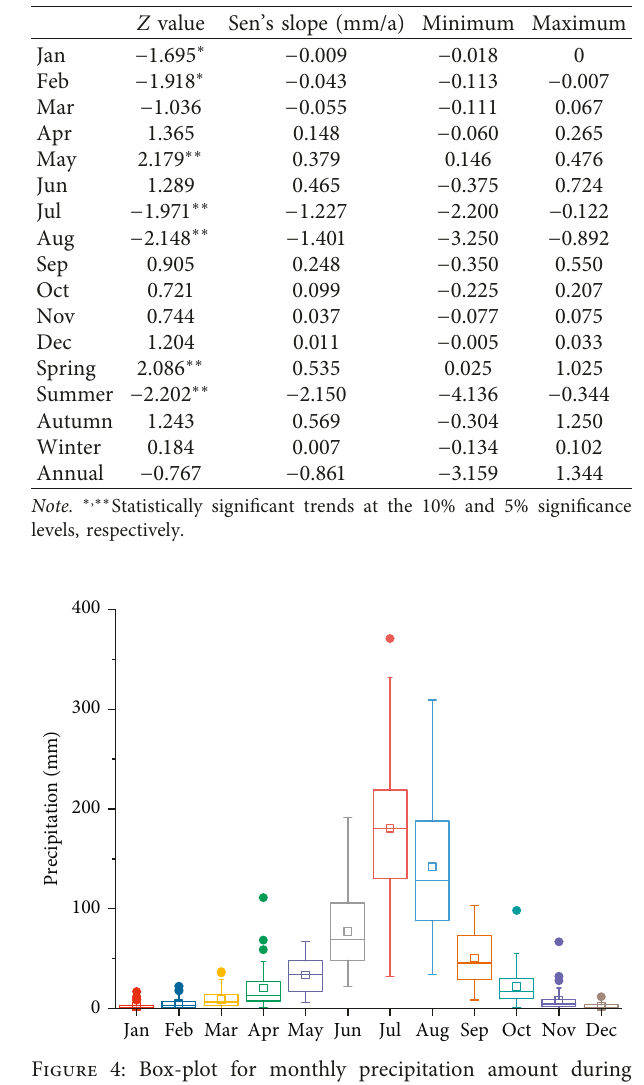
method. Then, the changes in the two samples before and